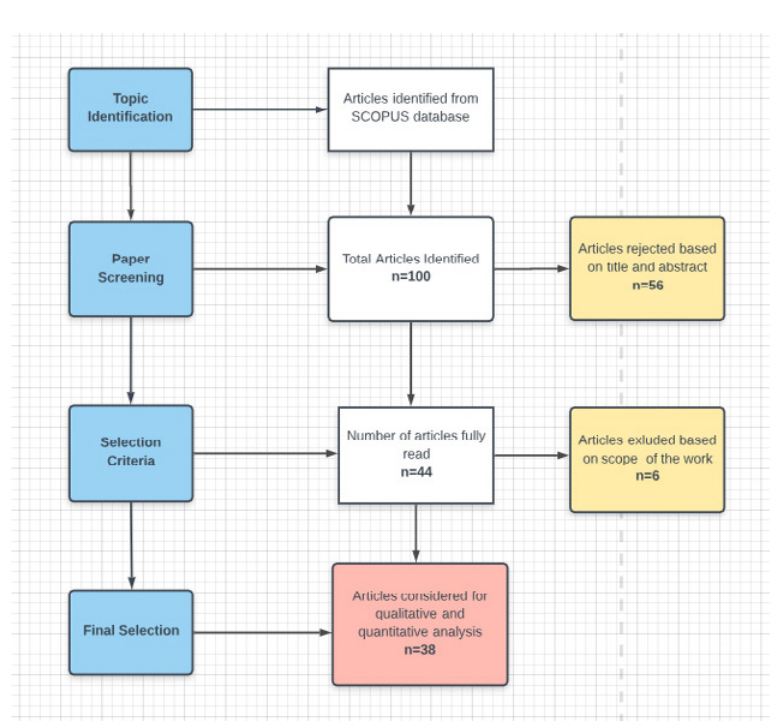
Fig. 1: Flowchart of systematic selection of articles for qualitative and quantitative analysis